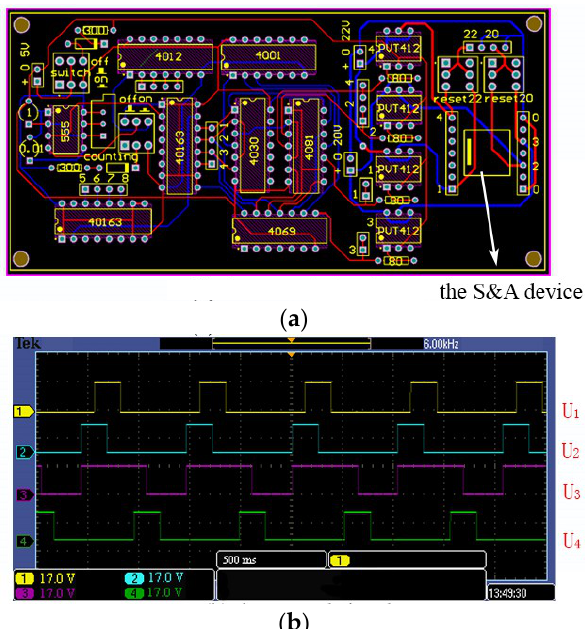
Figure 15. The control circuit and the control signal. ( a ) The control circuit. ( b ) The control